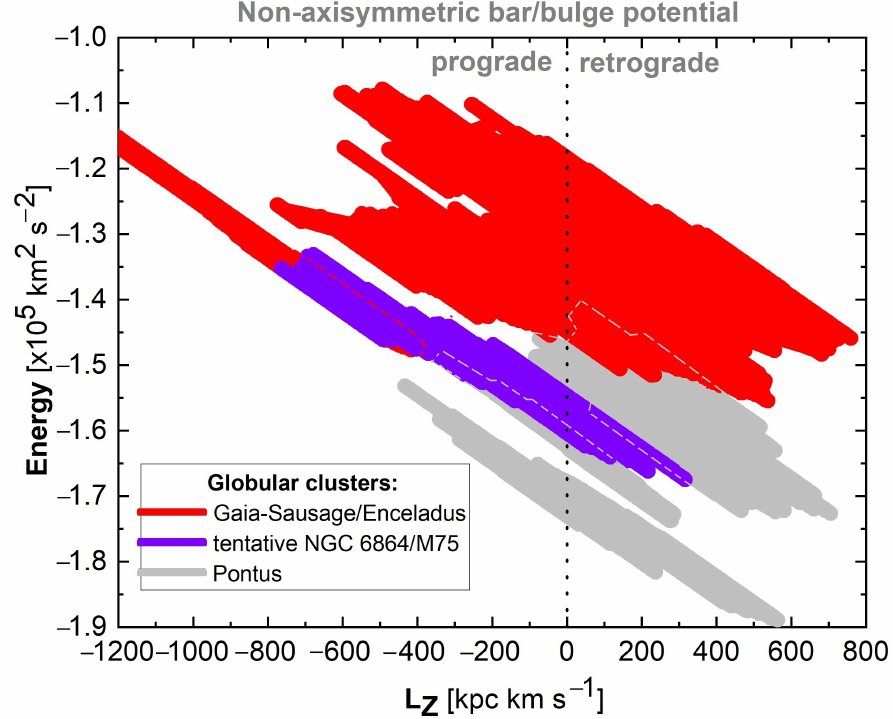
Figure 9. Evolution of the globular clusters from Table 1 during 4 Gyr after the beginning of simula- tions, taking into account the non-axisymmetric potential of the rotating bar and the observational errors of the initial